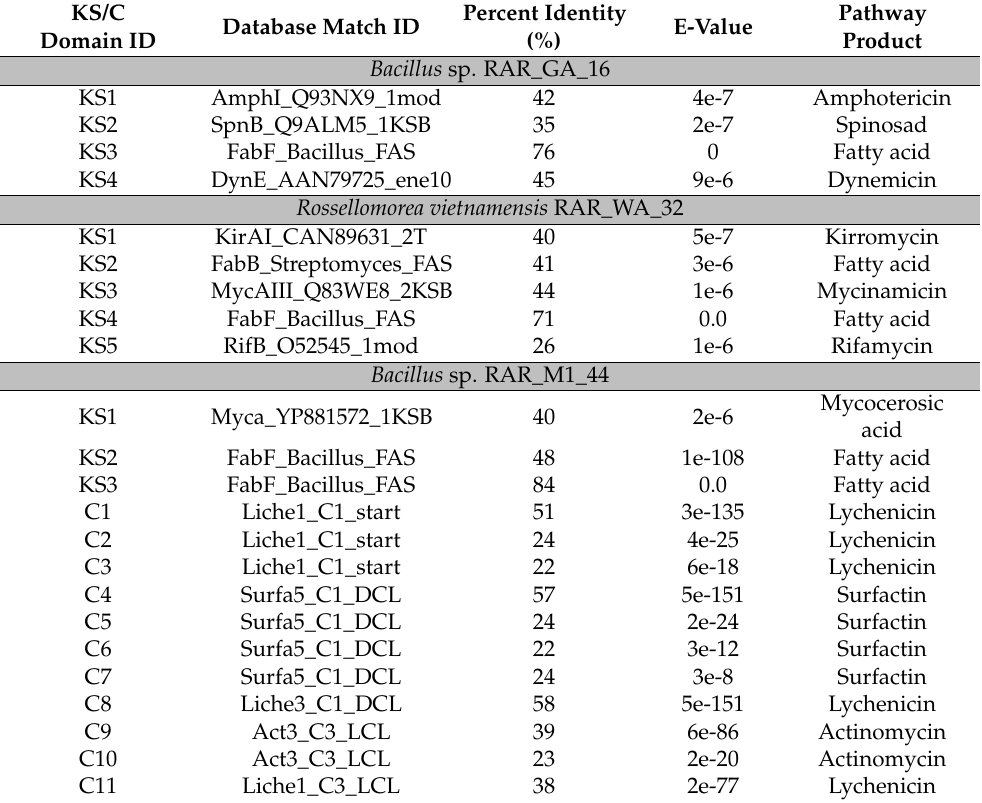
Table 9. Predicted pathway products of KS and C domains from the bacterial